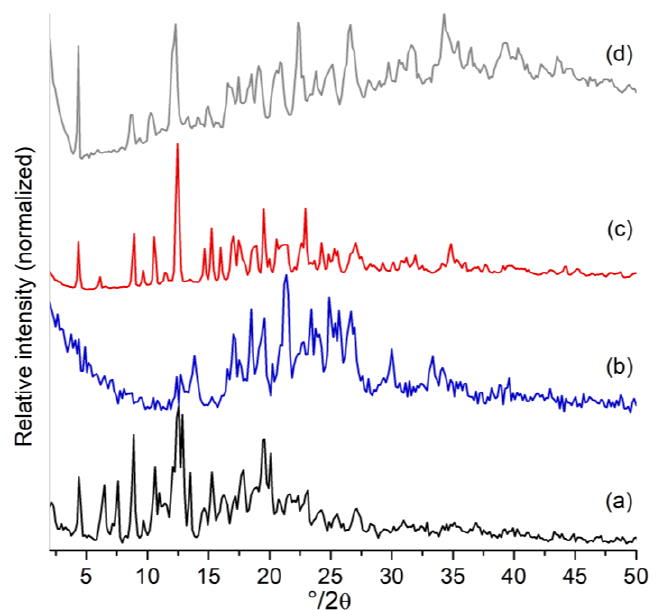
Figure 2. Powder diffractograms of ( a ) βCD, ( b ) Mel, ( c ) βCD– Mel, and ( d ) physical mixture of βCD and Mel.